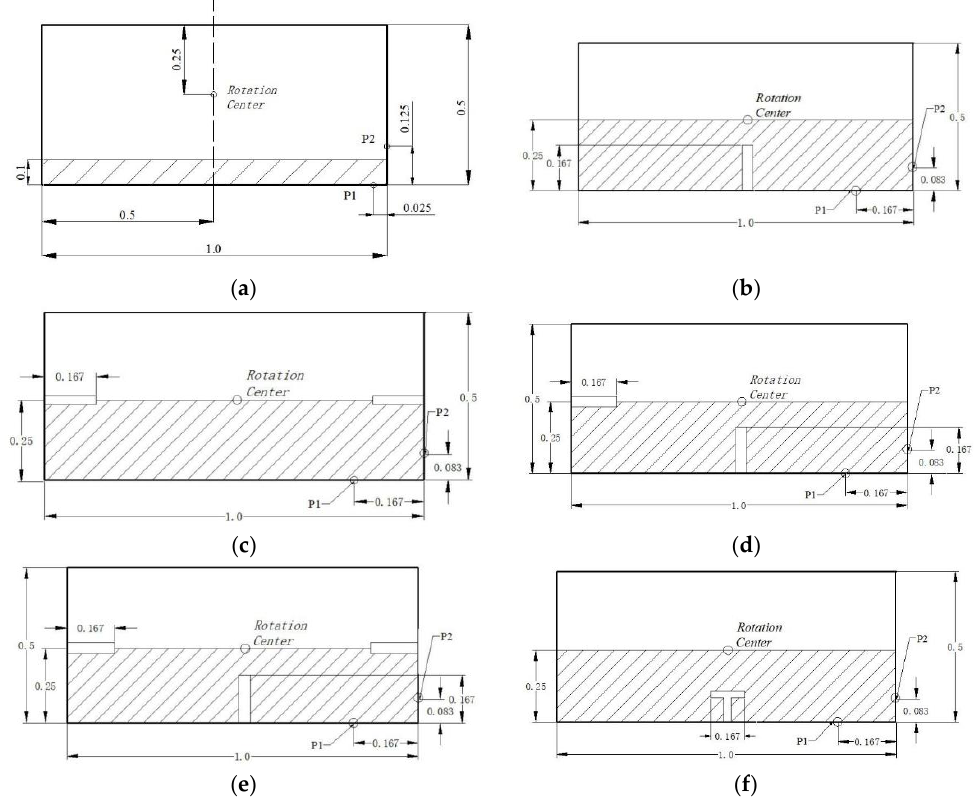
Figure 5. Different configurations of the baffles for sloshing tank: ( a ) reference case without baffle; ( b ) one vertical baffle; ( c ) two horizontal baffles; ( d ) one vertical and one horizontal baffle; ( e ) one vertical and two horizontal baffles; ( f ) one T-shaped baffle.